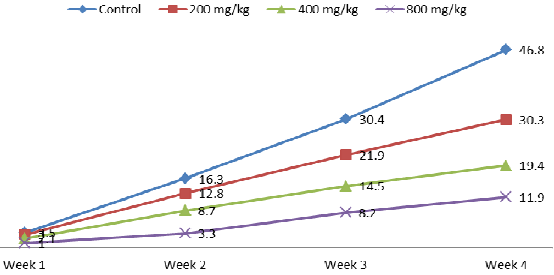
Fig. 2. Effect of Lipton tea aqueous extract on fasting blood sugar (mg/dl) of normal albino